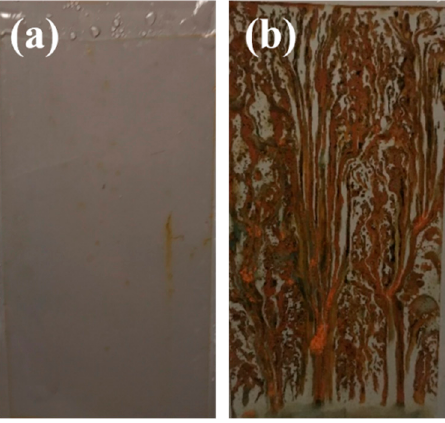
Figure 5. The NSS results: ( a ) coated plate for 48 h and ( b ) blank plate for 2 h.